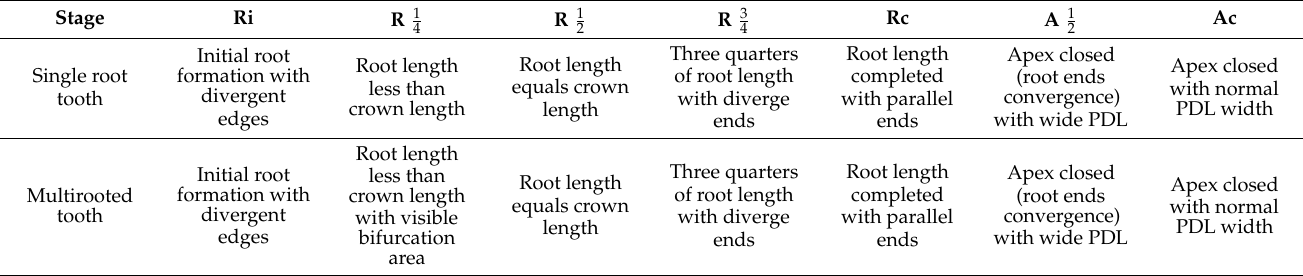
Table 1. A modified seven-stage London Atlas of tooth development for single-rooted and multi- rooted teeth